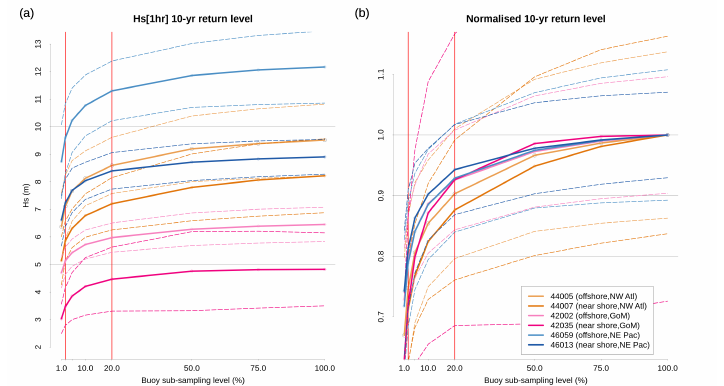
Figure 10. 10-year return levels computed from 1-h averaged buoy measurements of Hs as a function of percentage of total possible sampling at a number of nearshore and offshore buoys. Solid lines show the point estimate (based on an iterative average) and dashed lines show the upper and lower 95% confidence bounds. Red vertical lines indicate the 2.5% and 20% sampling levels. ( a ) shows absolute value of return level. ( b ) shows the same values but normalised to the value obtained from the totality of the